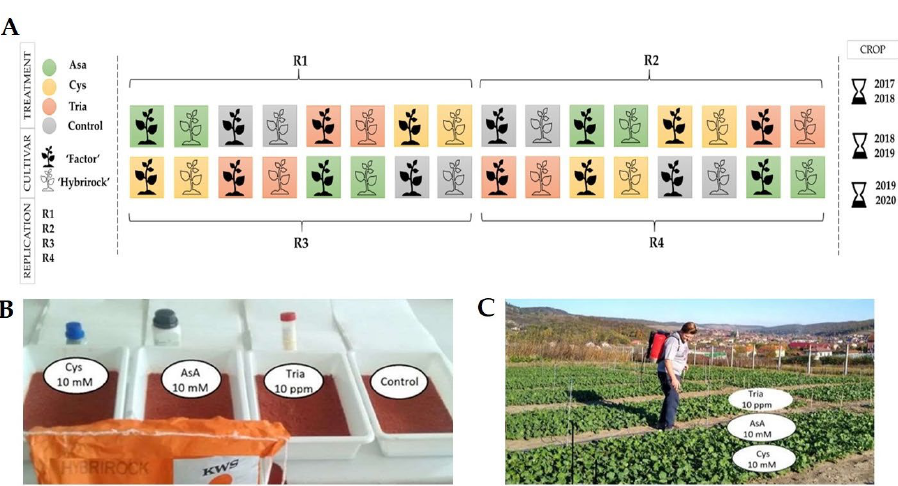
Figure 1. The experimental treatments and design. ( A ) Experiment layout: two canola cultivars un- der four treatments during three-year study. ( B , C ) Aspects of the seed treatments and the canola crop